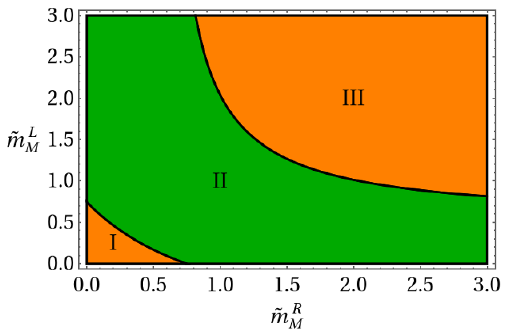
Figure 5 . Region plot showing the sign of M and III (orange/brighter) correspond to M